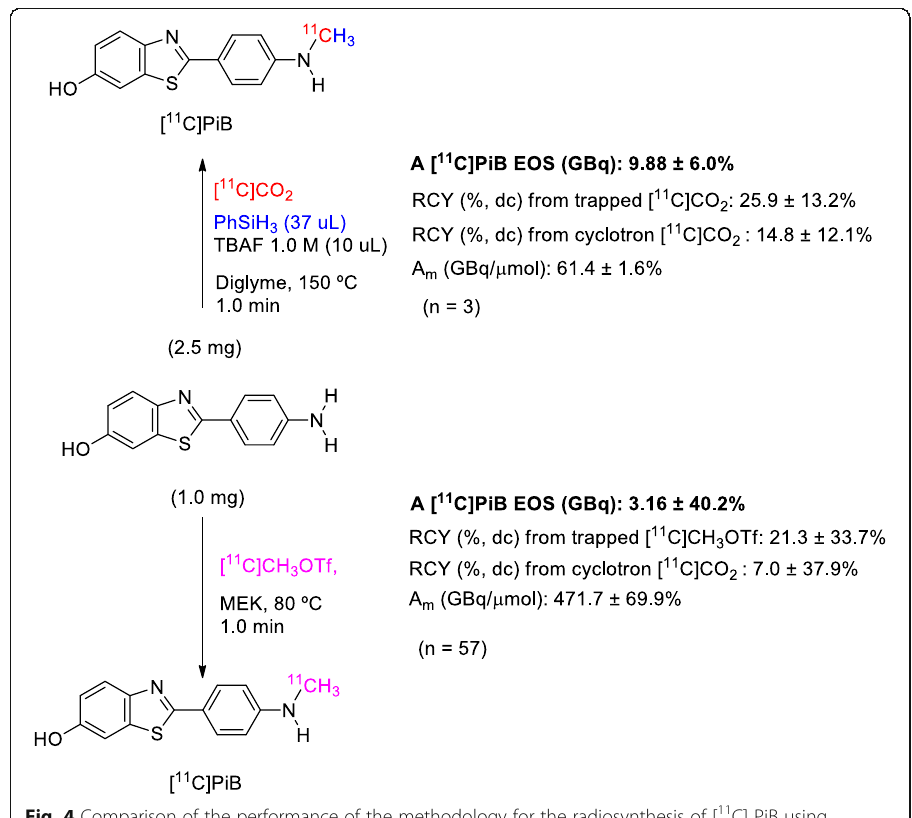
Fig. 4 Comparison of the performance of the methodology for the radiosynthesis of [ 11 C] PiB